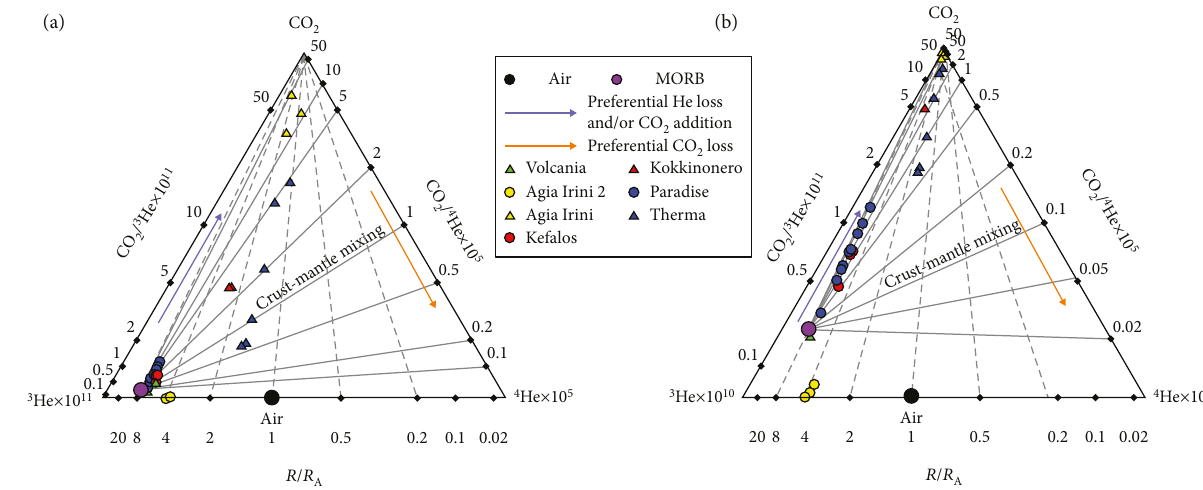
Figure 3: (a) CO - 3 He- 4 He ternary diagram and (b) CO 2 lines between mantle-derived and crustal volatiles. Dashed lines show the e ff ects of shallow-level phase